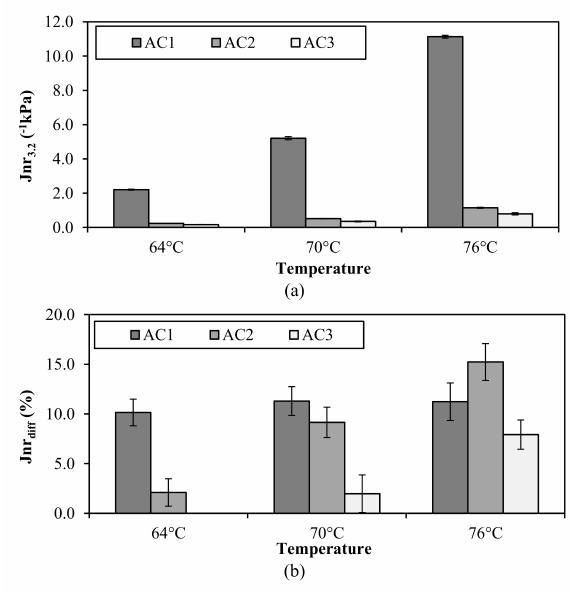
Figure 5: MSCR results at three different temperatures: (a) Jnr at 3.2 kPa and (b) Jnr diff